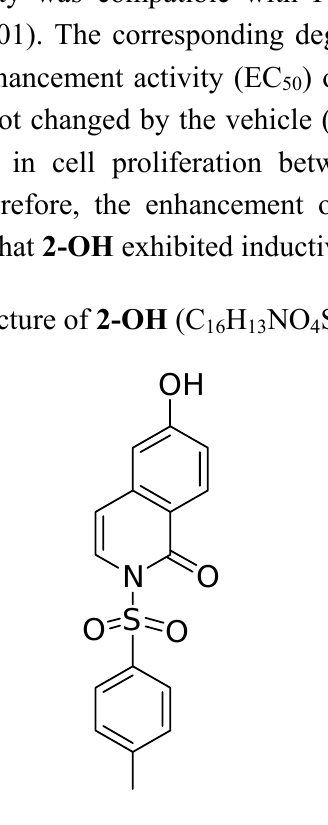
Figure 2. Effects of 2-OH on PBMC proliferation. PBMC (2×10 5 /well) were treated